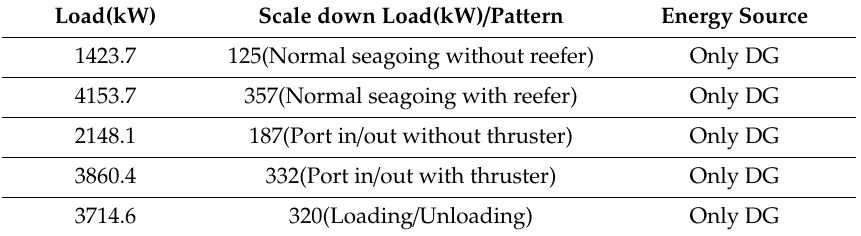
Table 4. The load profile applied to the experiment (5500TEU Reefer Container